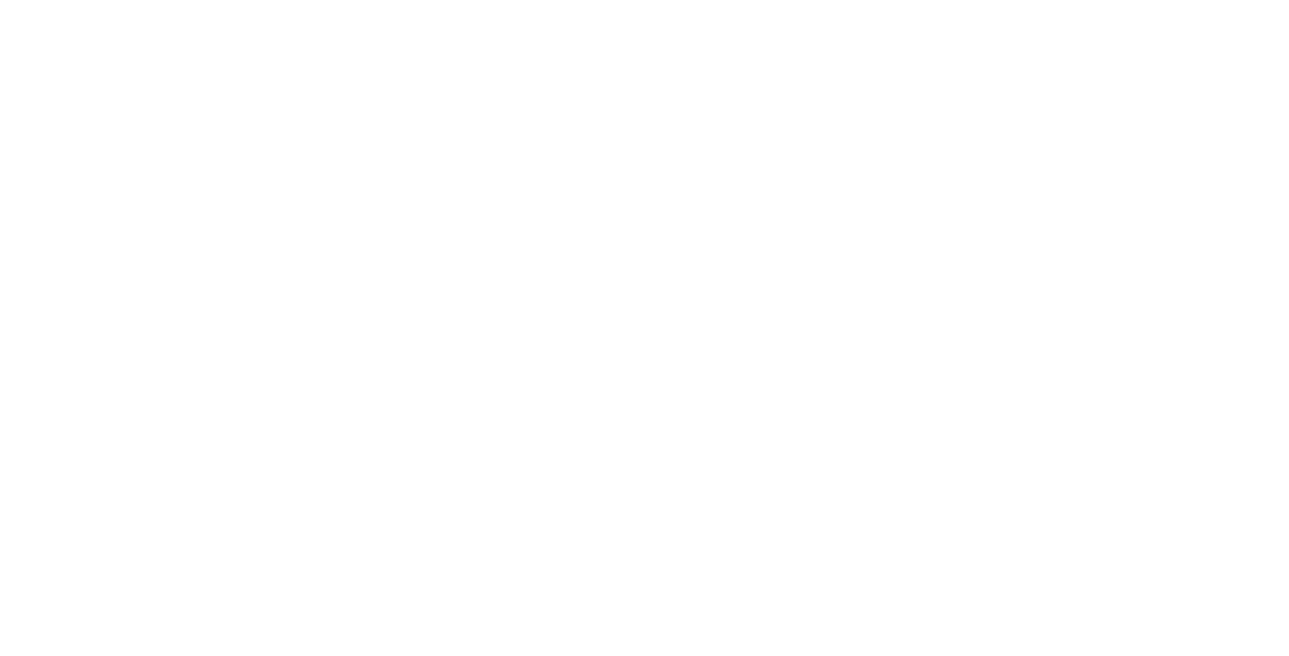
Frontiers in Robotics and AI |